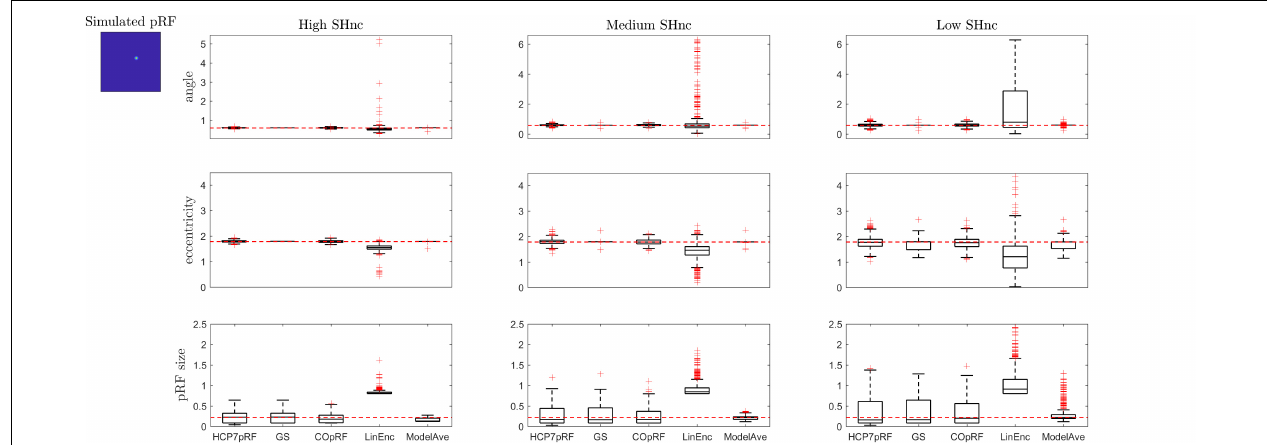
FIGURE 6 | Boxplots ([25, 50, 75] percentiles over 1000 simulated datasets) represents the estimated pRF parameters using different estimation procedures for a narrow two-dimensional pRF (presented in extreme left). Each column refers to a different split-half noise ceiling level from high to low: High SHnc = 0.63, Medium SHnc = 0.35, Low SHnc = 0.1. Each row presents the results for each of the pRF parameters: angle, eccentricity and pRF size. Outliers (in the estimated pRF parameters) are denoted by red + symbols and defined by the condition of being outside the 1.5 interquartile range. The horizontal red line indicates the pRF parameters used to simulate the